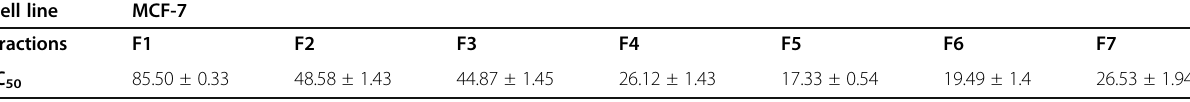
All values in mean ± SEM ( n =3), F =